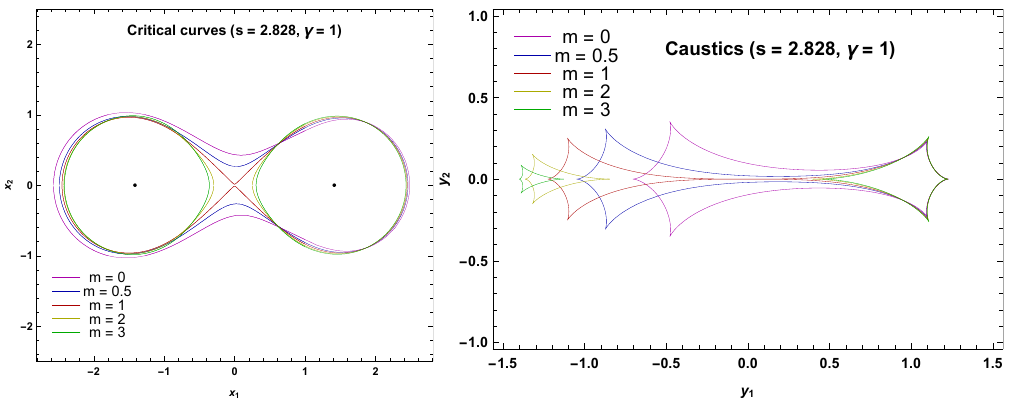
Figure 2. Critical curves and caustics in the equal-strength binary, intermediate-wide